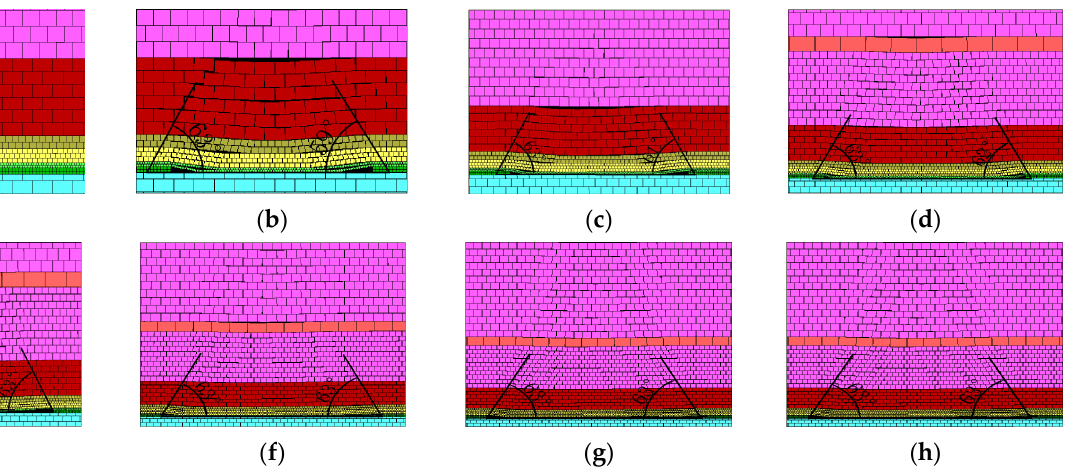
Figure 6. The movement and deformation of mining strata under multi-aquifer. ( a ) Working face advance 50 m. ( b ) Working face advance 100 m. ( c ) Working face advance 150 m. ( d ) Working face advance 200 m. ( e ) Working face advance 250 m. ( f ) Working face advance 300 m. ( g ) Working face advance 350 m. ( h ) Working face advance 400 m.